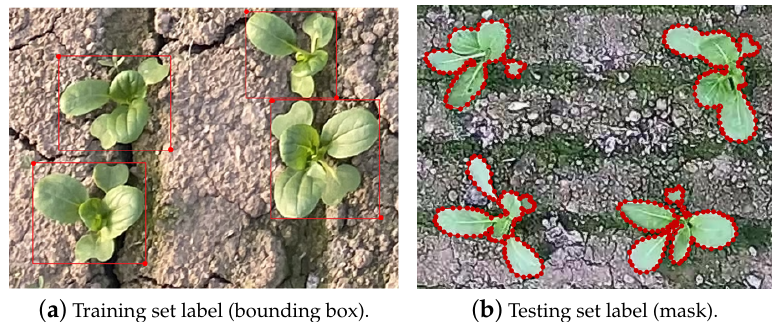
Figure 2. Annotation results of edge points of green leafy vegetables. The annotations for the training set, shown in Sub-figure ( a ), are bounding boxes. The annotations for the testing set, shown in Sub-figure ( b ), are masks.